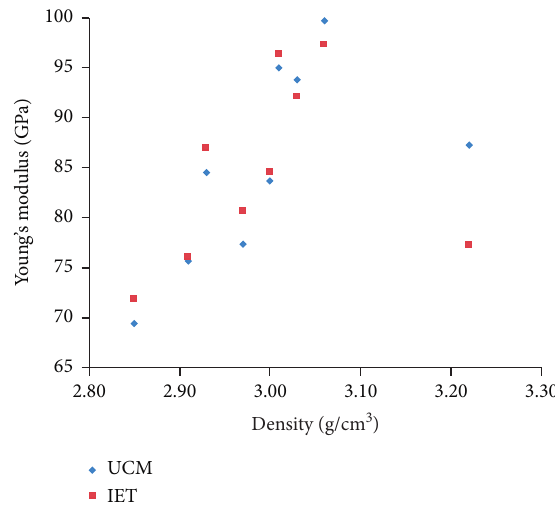
Figure 5: Density x Young’s Modulus by IET and UCM.